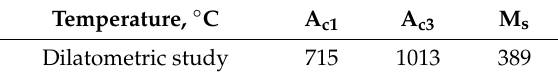
Figure 1. Schematic of heat treatments performed during the tests.